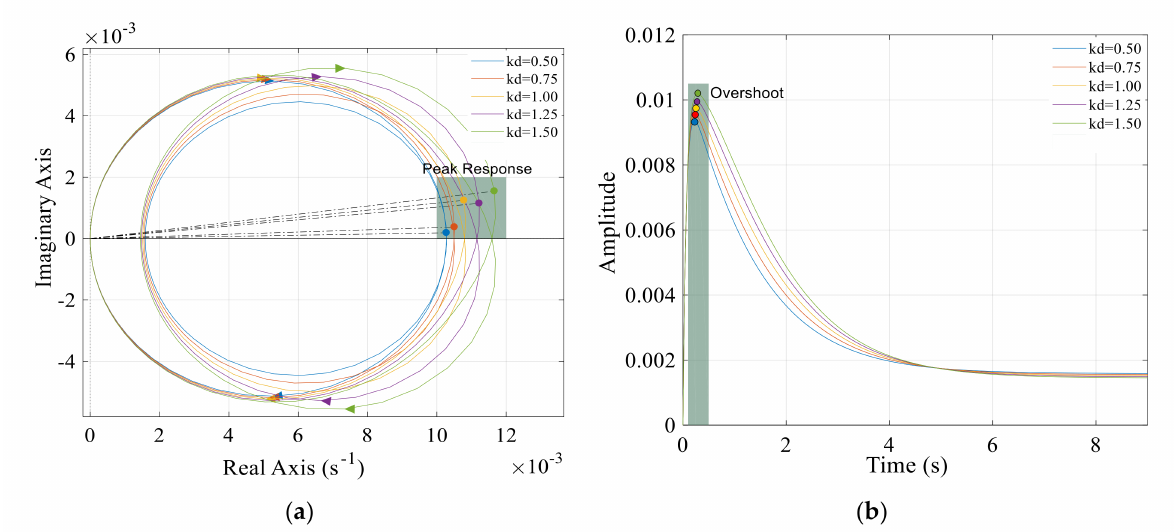
Figure 15. Nyquist and step responses to the variation of the differential adjustment coefficient, k d = [0.5, 1.5]. ( a ) Nyquist response, and ( b ) step